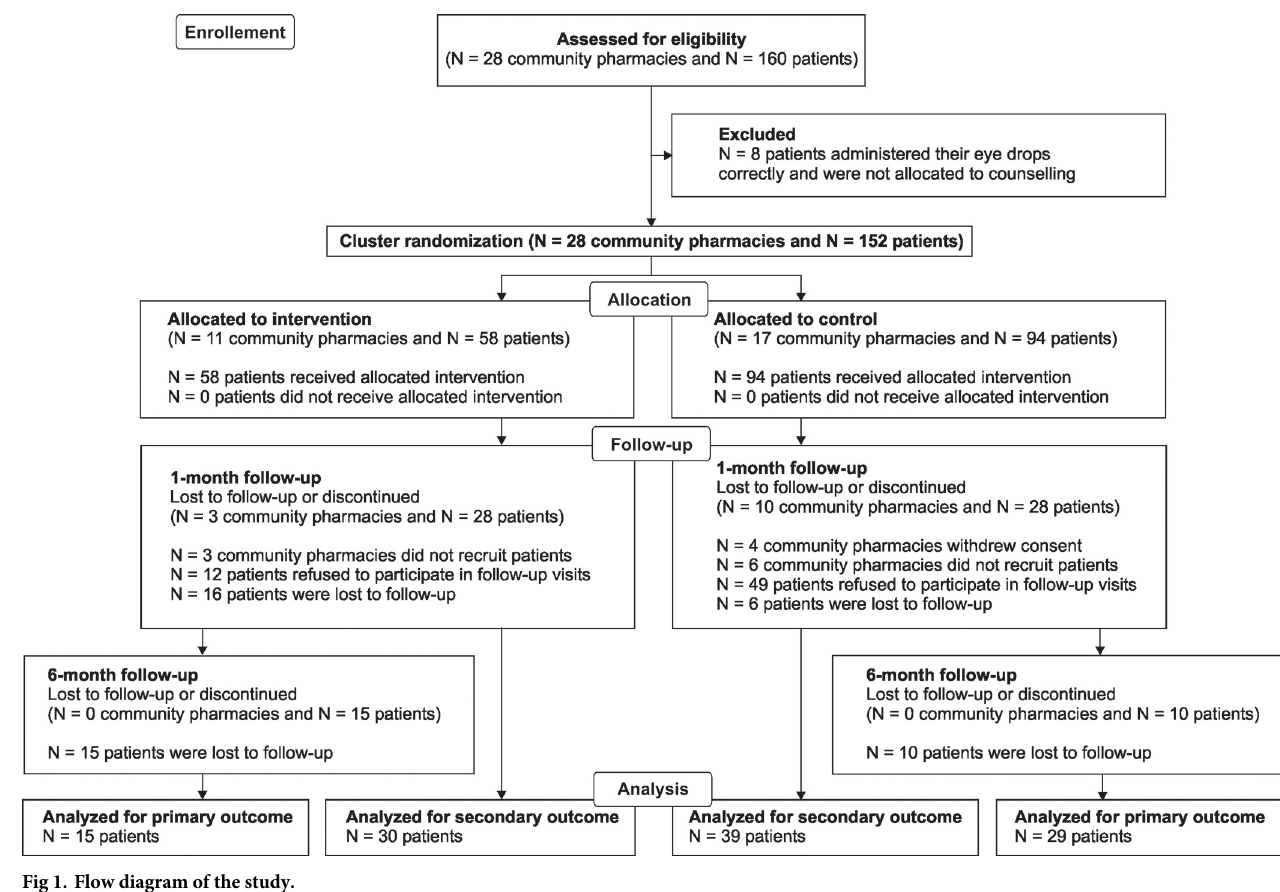
Fig 1. Flow diagram of the study.